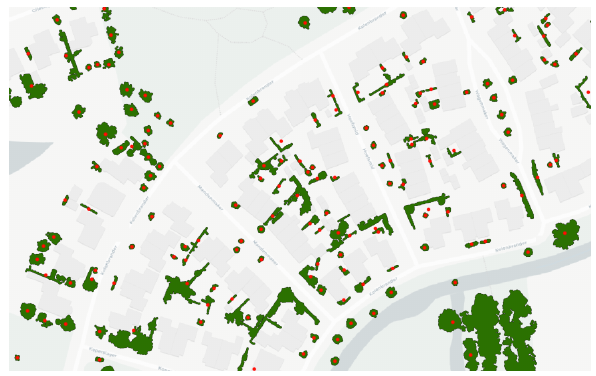
Figure 13. Sample of ImplicitGeometry Trees in Rijssen-Holten ure 13 that do not contain a centroid are modelled as 3D Plant- Cover CityObjects.